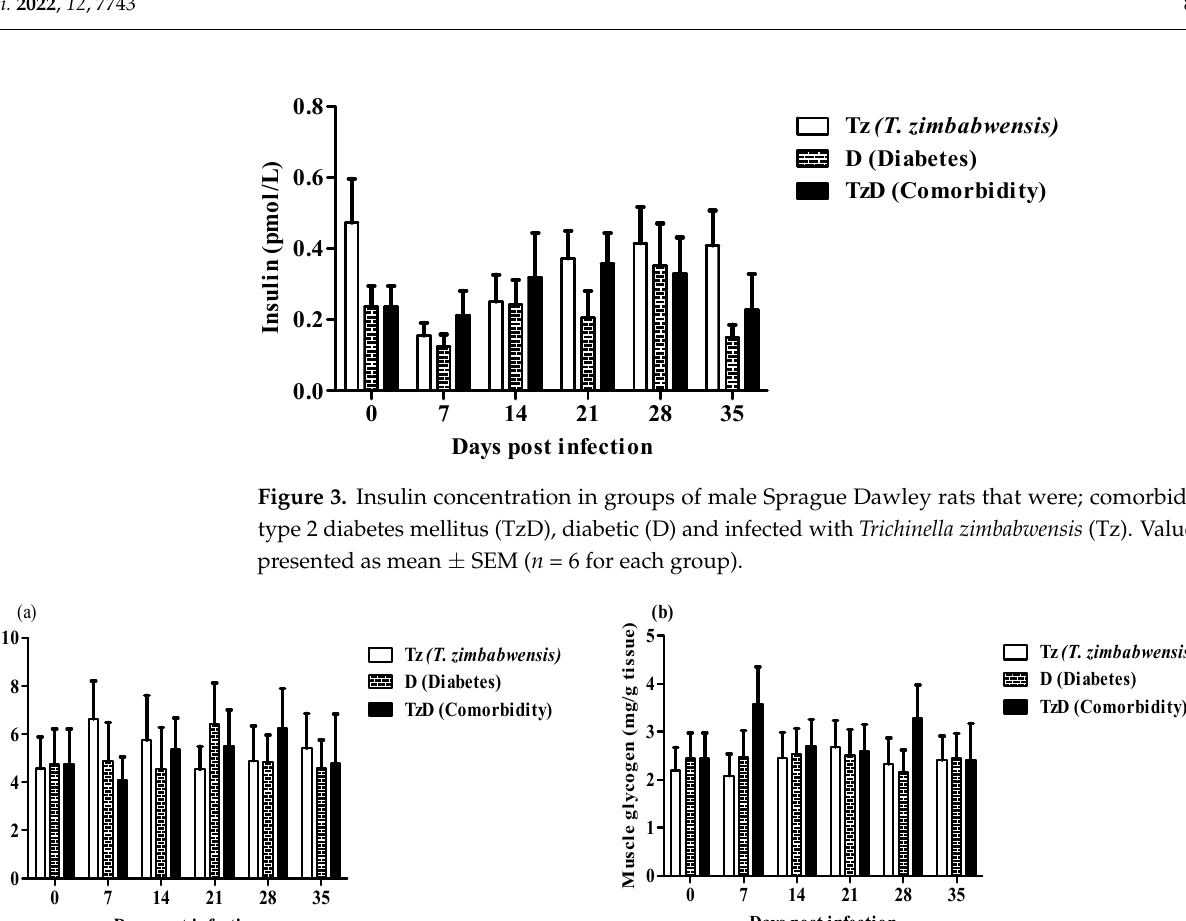
Figure 4. Liver glycogen concentrations ( a ) and muscle glycogen concentrations ( b ) in male Sprague Dawley rats that were; comorbid with type 2 diabetes mellitus (TzD), diabetic (D) and infected with Trichinella zimbabwensis (Tz). Values are presented as mean ± SEM ( n = 6 in each group).